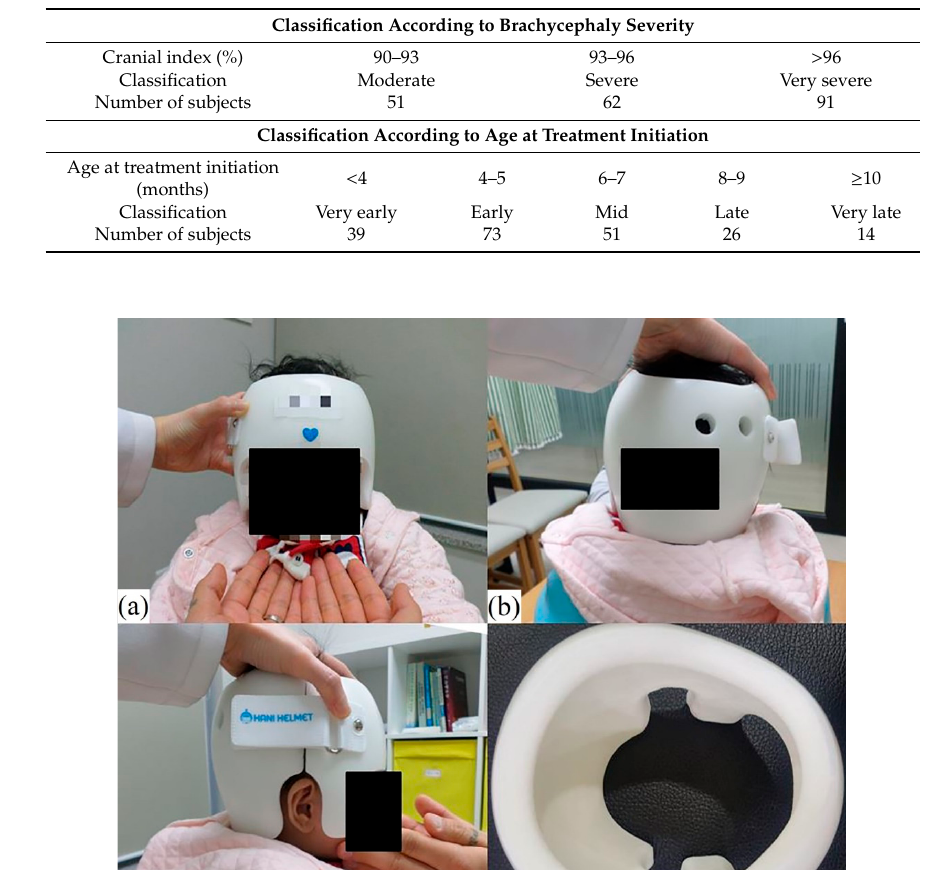
Table 1. Classification of subjects according to brachycephaly severity and age at treatment initiation ( n = 207).